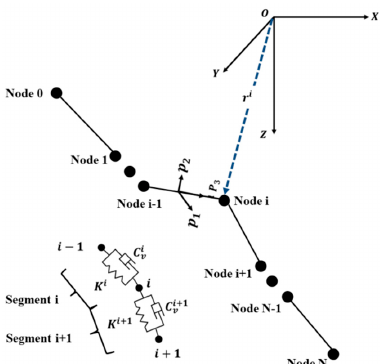
Figure 7. Thrust force measurement of the UUV.